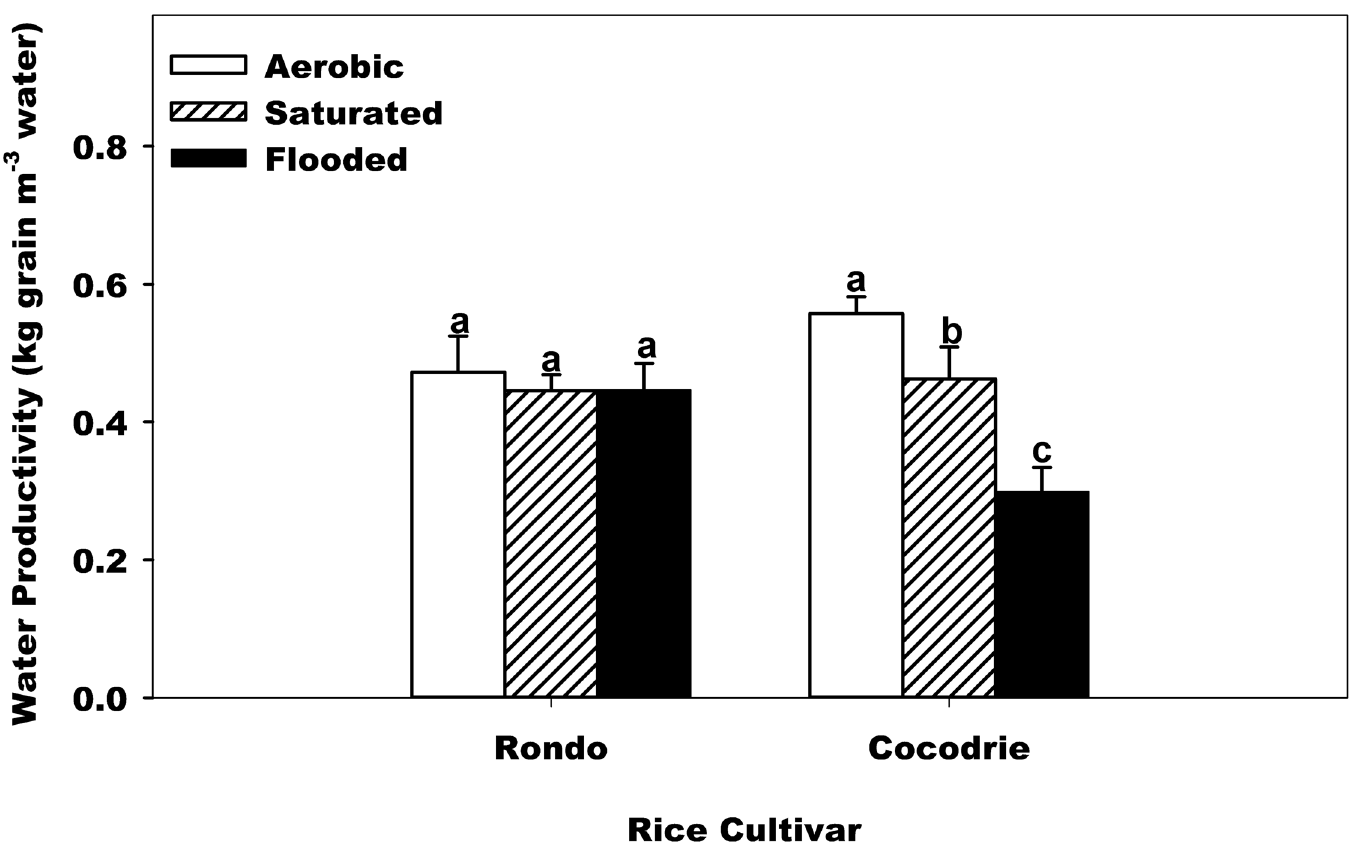
Fig 5. Effect of water regime and cultivar across soil texture on the water productivity (kg grain m -3 water). Error bars denote the standard error of the mean. Bars with the same letters above are not significantly different based on Fisher ’ s protected LSD ( P = 0.05) within the